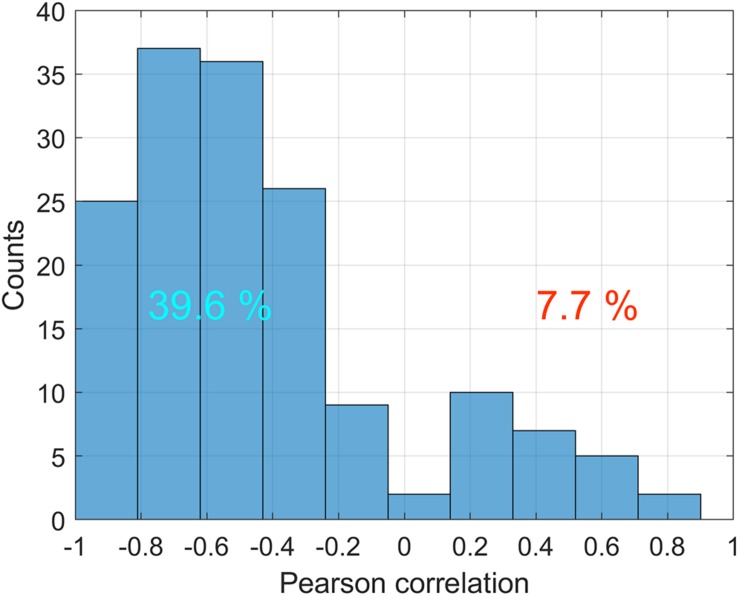
Distribution of correlation coefficients between ABP and APC in various big ROIs during different stimulation sessions for all 11 rats. Only statistically significant cases are counted. Numbers on the positive and negative parts show percentages of statistically significant correlations with positive and negative signs, respectively.